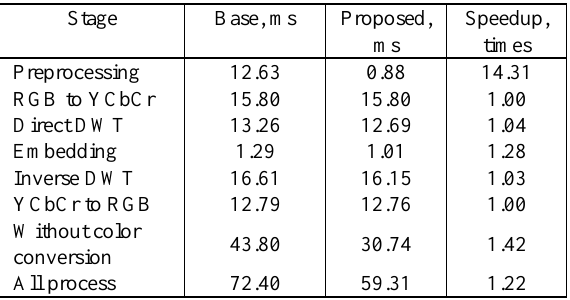
Table 5. Comparison of basic and proposed